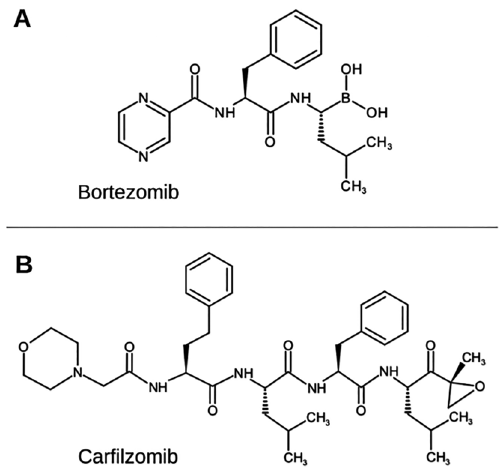
Figure 1. Bortezomib and Carfilzomib. Chemical structures of Bortezomib ( A ) and Carfilzomib ( B ) are reported (structures drawn using ACD/ChemSketch 14